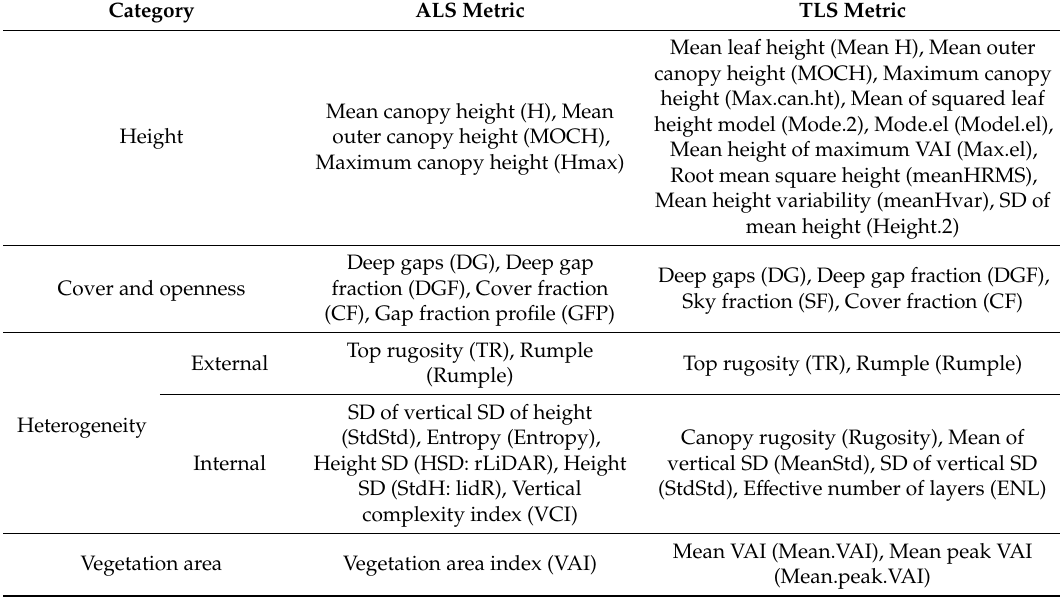
Table 2. Categories of forest structural diversity and metrics from terrestrial laser scanning (TLS) and aerial laser scanning (ALS) platforms. Details on the derivation and R functions used to calculate structural metrics can be found in Atkins et al. [10] for TLS and Supplementary Materials Table S1 for ALS. The abbreviations of metric names are listed in